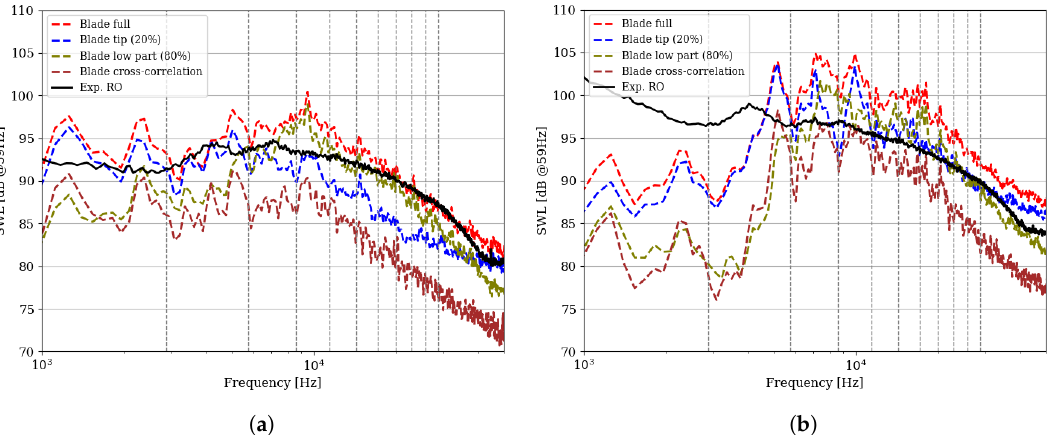
Figure 16. Sound power level spectra from the experiments (black solid line), the Ffowcs Williams and Hawkings (FWH) analogy for the full blade (red dashed line), the tip region (blue dashed line), the low part of the blade (beige dashed line) and the cross-correlation part between them (brown dashed line). The dashed grey lines indicate the blade passing frequencies. ( a ) Upstream propagation direction. ( b ) Downstream propagation